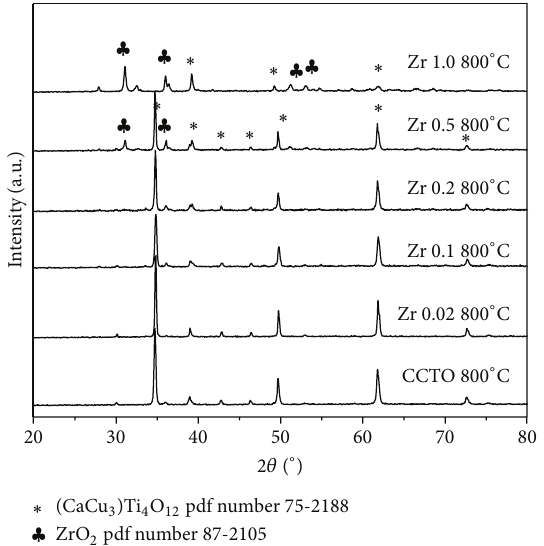
Figure 1: XRD patterns of CCTO and CaCu 3 Ti 4−𝑥 Zr 𝑥 O 12 ( 𝑥 = 0.02 , 0.10, 0.20, 0.50, and 1.0mol%) calcined at 800 ∘ C for